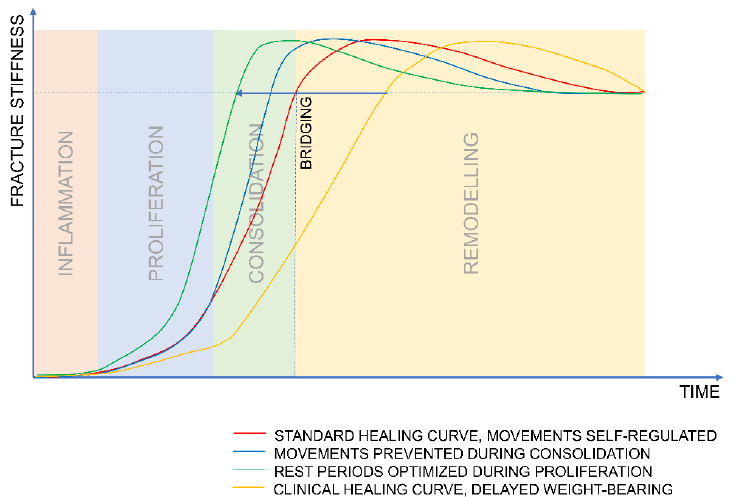
Figure 3. Hypothesized benefit of the optimized stimulation protocol in reducing healing time in comparison to current clinical practice.